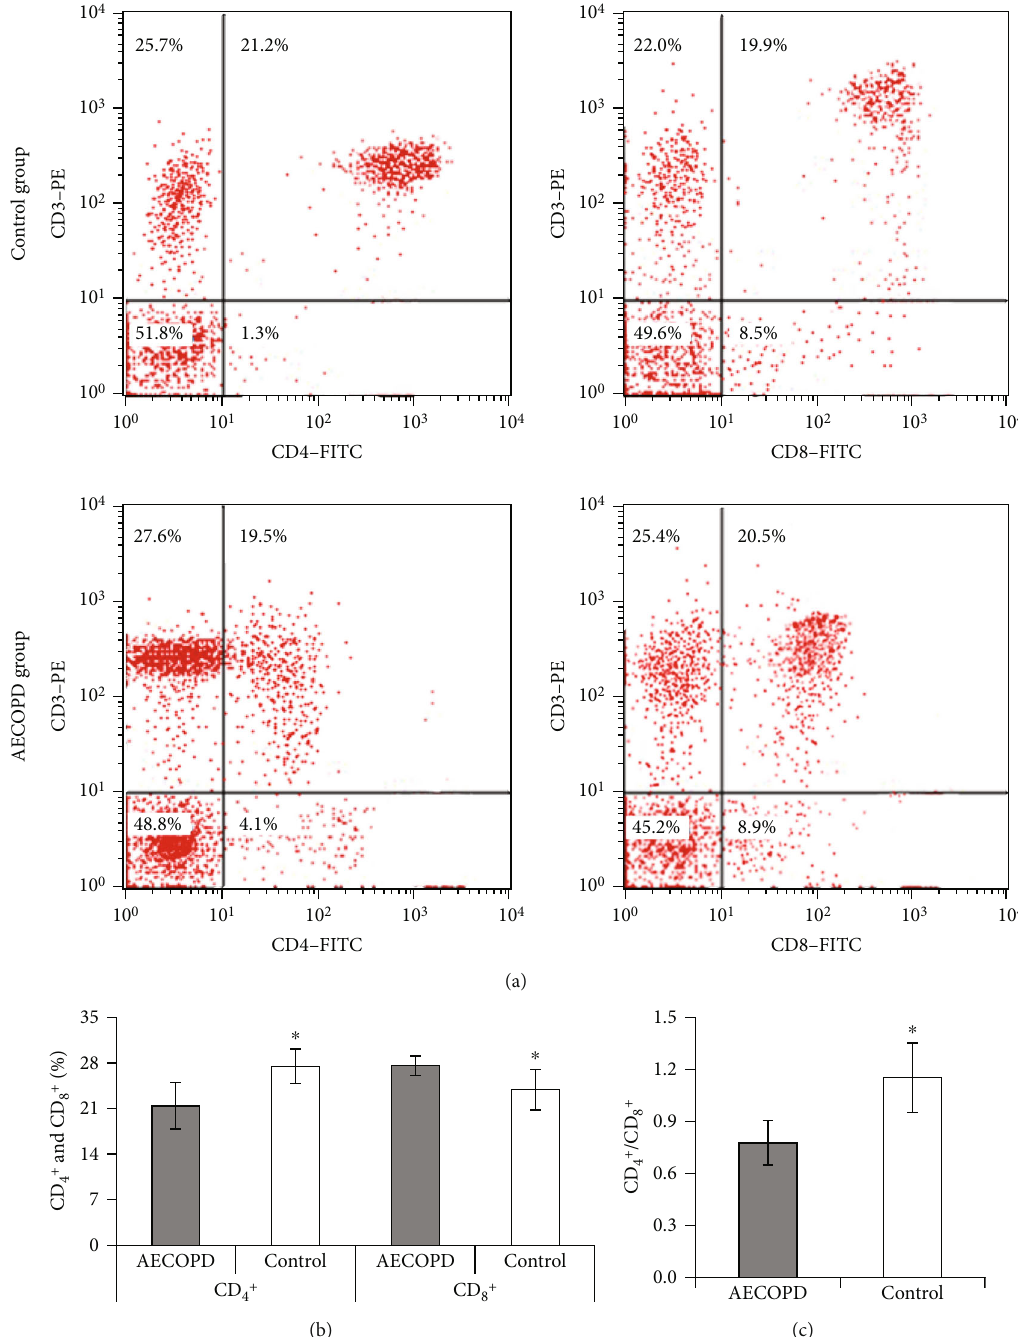
Figure 4: Comparison of CD 4+ and CD 8+ T lymphocyte levels in PB. Note: (a) CD 4+ and CD 8+ T lymphocyte fl ow cytometry; (b) CD 4+ T lymphocyte level; (c) CD 8+ T lymphocyte level; relative to AECOPD group, the distinction was statistically signi fi cant, ∗ P < 0 : 05